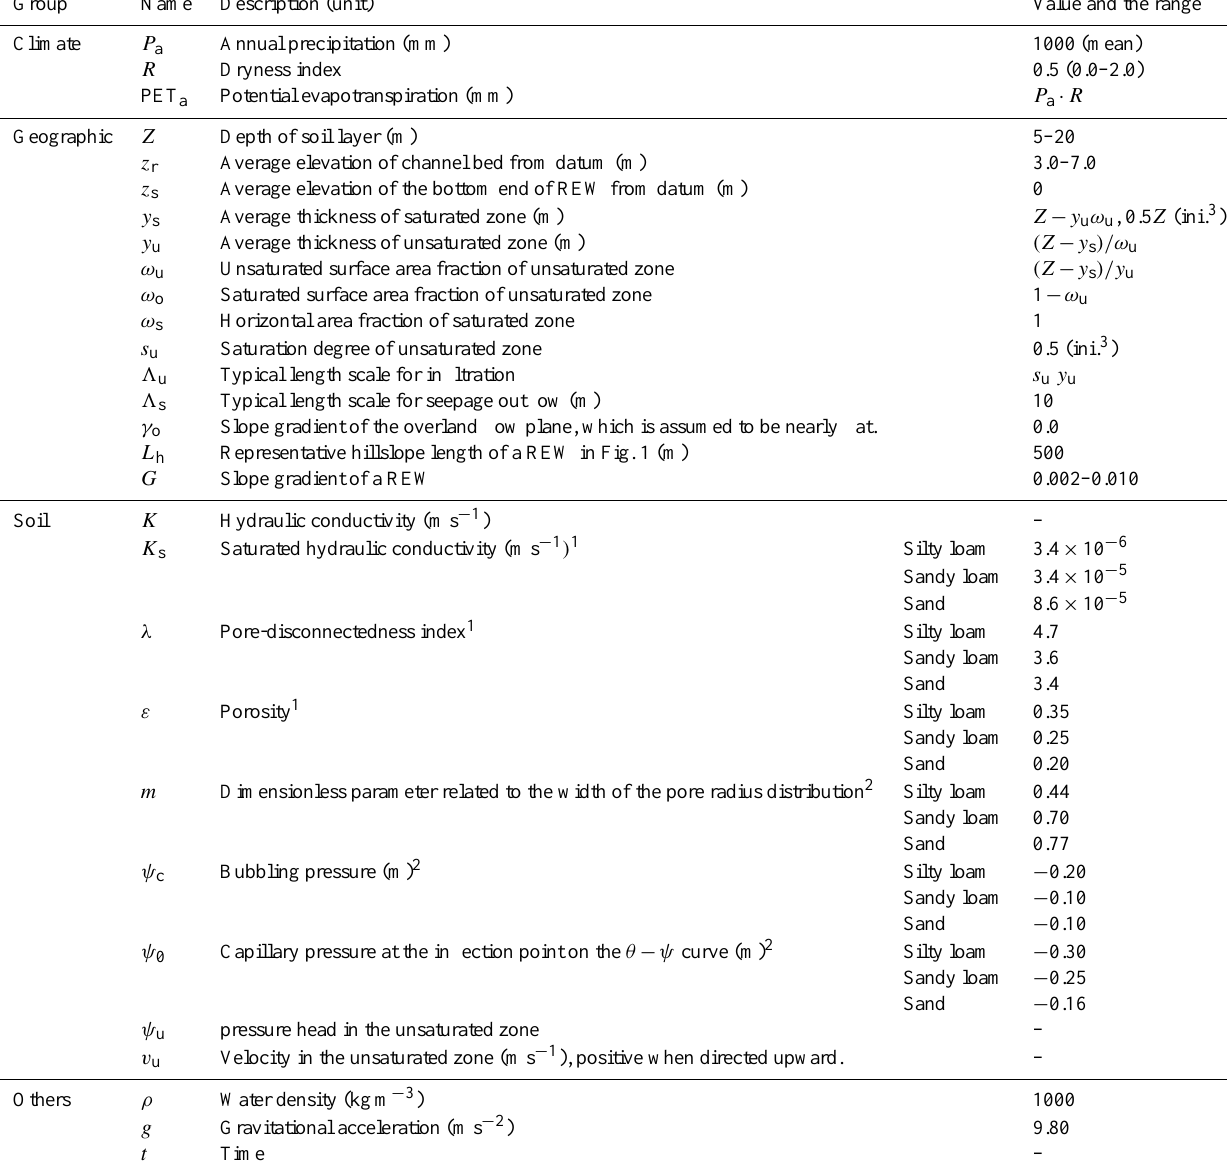
Table 1. Meaning, values and the ranges of model parameters used in the numerical experiments. Group Name Description (unit)